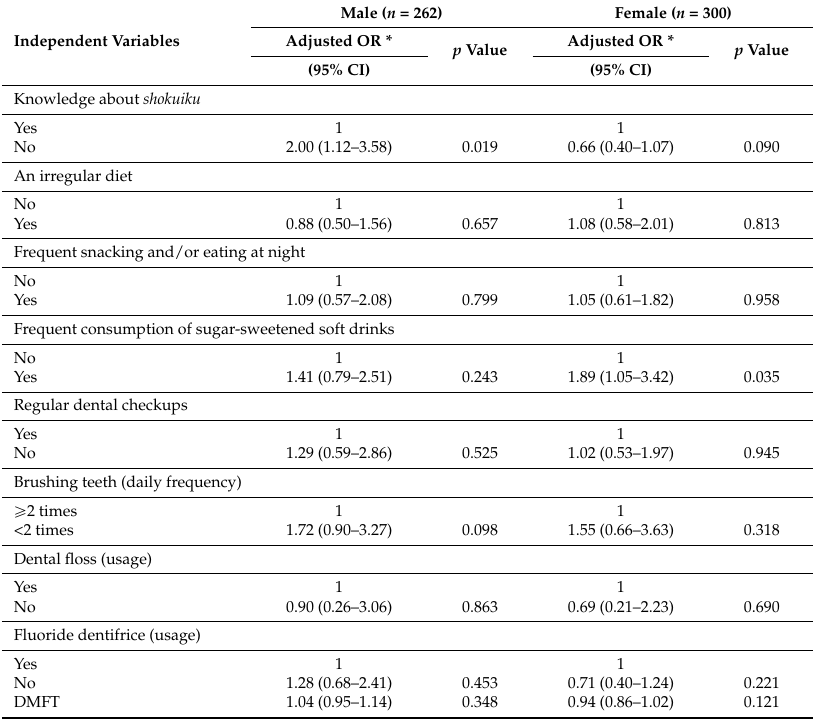
Table 4. Odds ratios regarding knowledge about comprehensive food education ( shokuiku ), dietary habits, and oral health